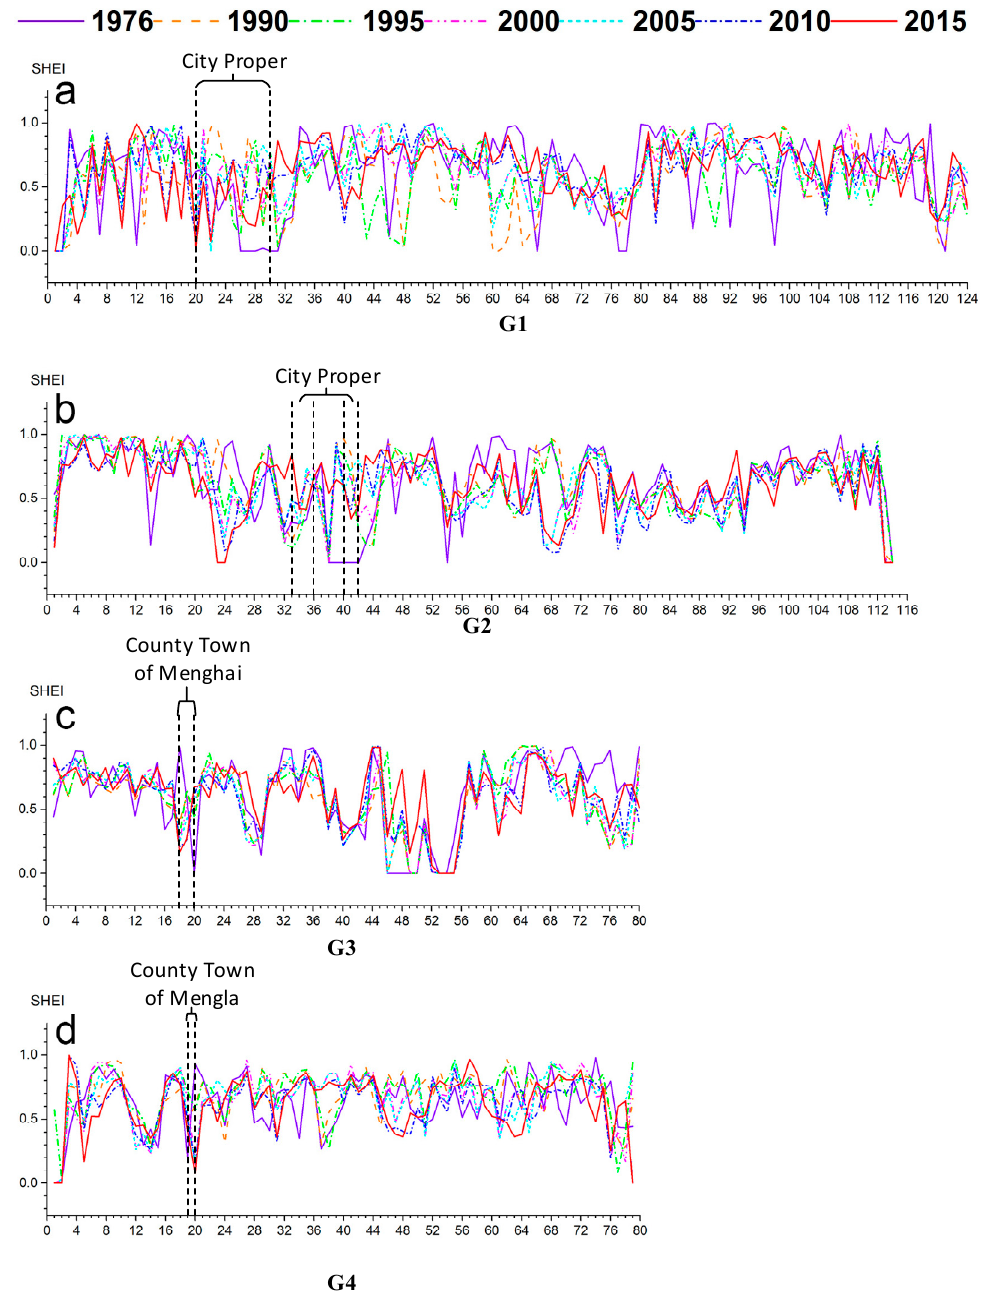
Figure 8. Shannon’s Evenness Index (SHEI) along four urban-rural gradients. X-axes represent the number of sampling blocks from the starting directions.